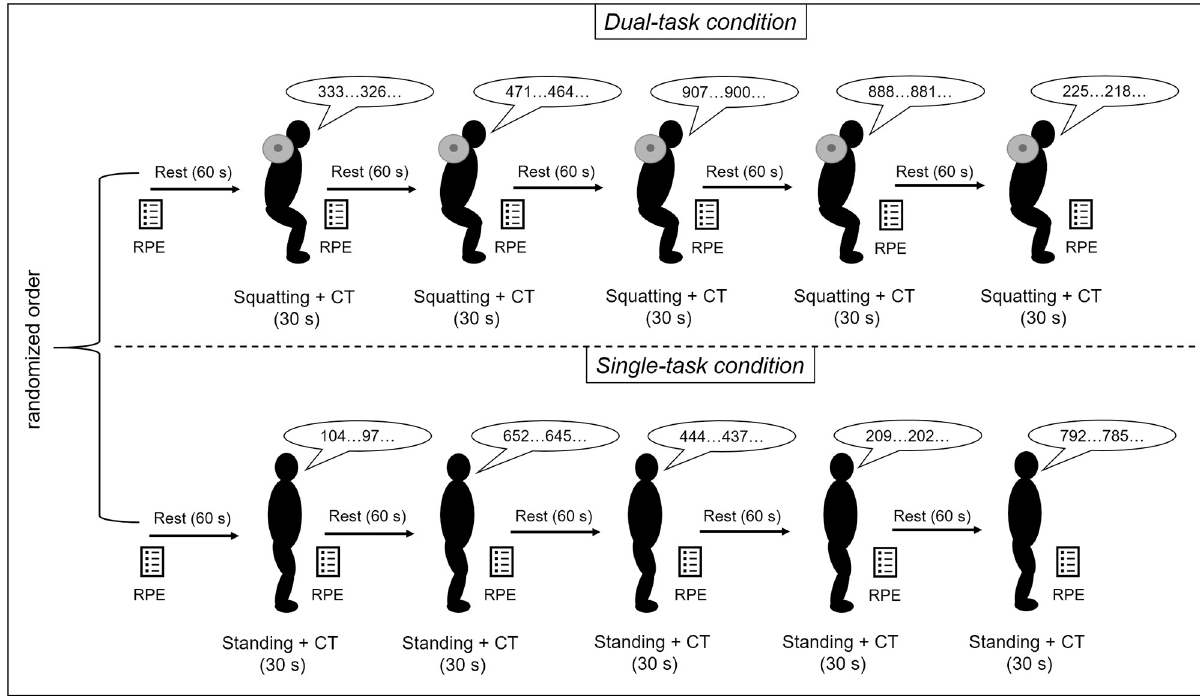
Fig 1. Overview of the experimental protocol in the second session and the time points of the assessment of RPE. The cognitive task was solved in a standing position (single-task) and during squatting (dual-task). Both tasks were performed for 30 seconds and afterwards the participants rested in a standing position for 60 seconds. RPE: Rating of perceived